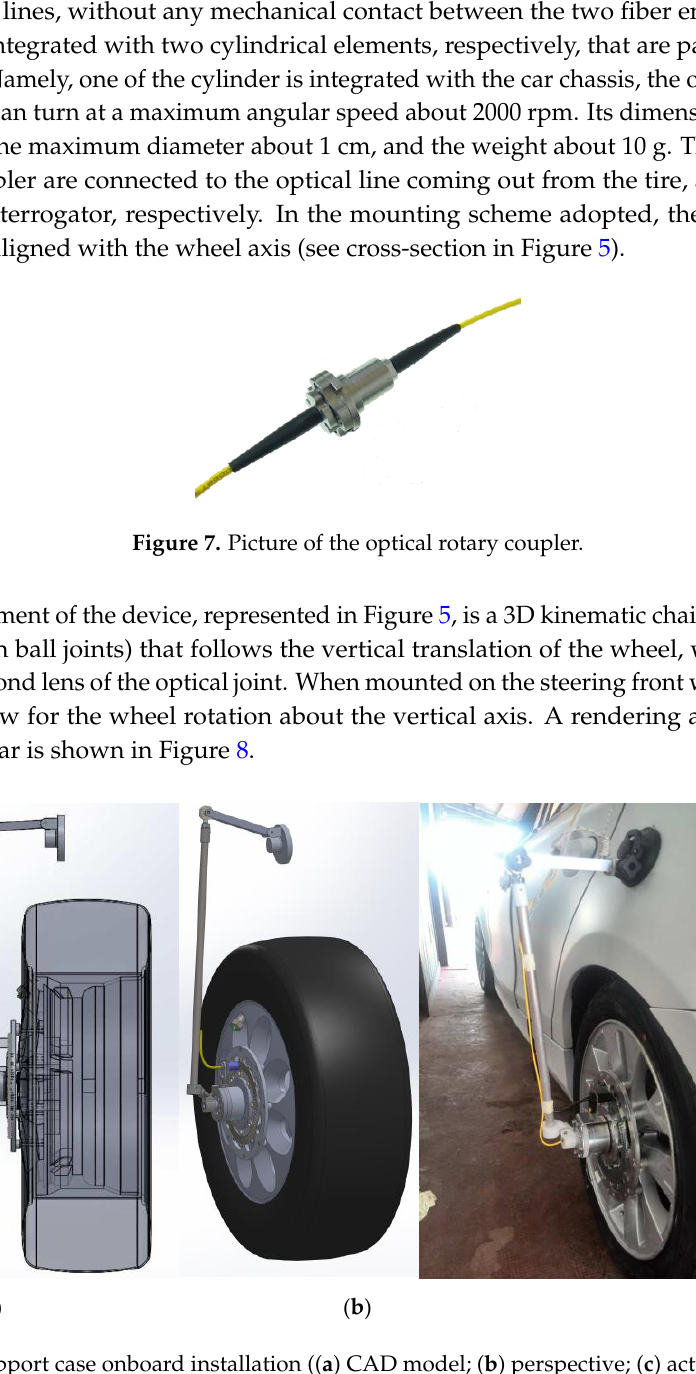
Figure 8. Support case onboard installation (( a ) CAD model; ( b ) perspective; ( c ) actual prototype).